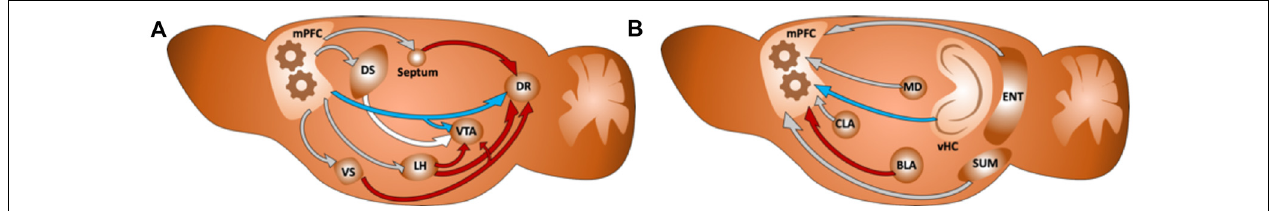
FIGURE 1 | (A) Diagram of a sagittal section of the rodent brain illustrating how the integration of information in the medial prefrontal cortex (mPFC) affects both directly (in blue) and indirectly (in red) monoaminergic nuclei in the brain, as an example for the top-down control of the mPFC. The rest of the connections are colored in gray. (B) Diagram illustrating some of the main inputs to the mPFC. We have colored in red the projection from the BLA and in blue the projection from the vHC: two regions we hypothesize to compete for target innervation in the mPFC. The rest of the connections are colored in